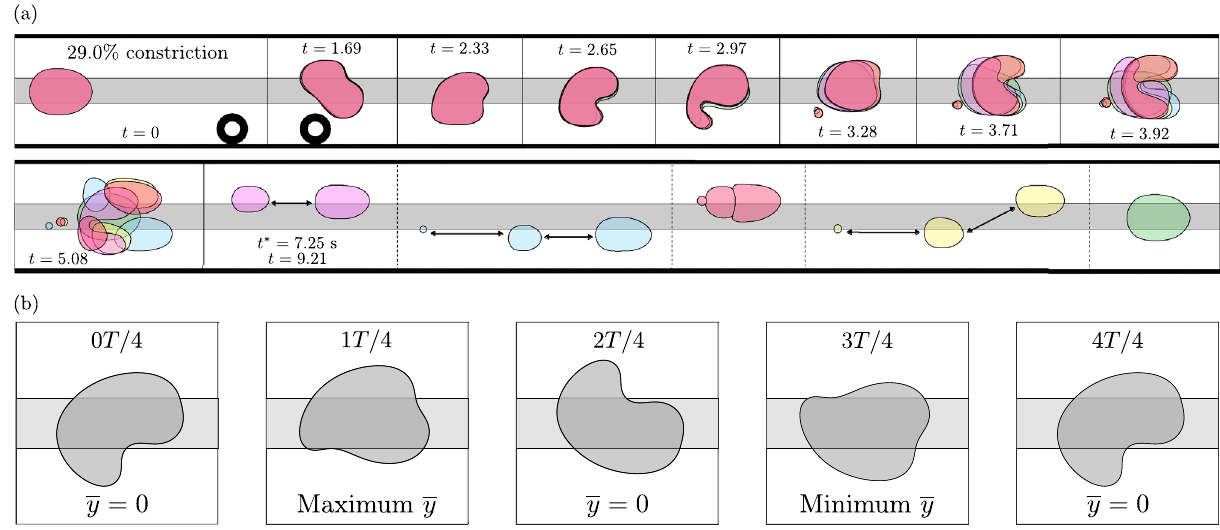
Figure 7. ( a ) Superimposed experimental time-sequences of bubble evolutions resulting from the circumvention of a larger obstacle that constricted the channel width by 29.0% . In each case, the dimensionless flow rate is Q = 0.023 . The bubble centroids are aligned in the streamwise direction. Arrows indicate long- term separation between bubbles. We note that snapshots of the final states are not superimposed, nor do they represent the relative position of each bubble in the channel. ( b ) Simulated time-sequence of the UPO dynamics for a bubble of size r = 0.54 at dimensionless flow rate Q = 0.037 in the depth-averaged model. The bubble is shown at equally-spaced time intervals of t = T / 4 , where T is the computed period of the